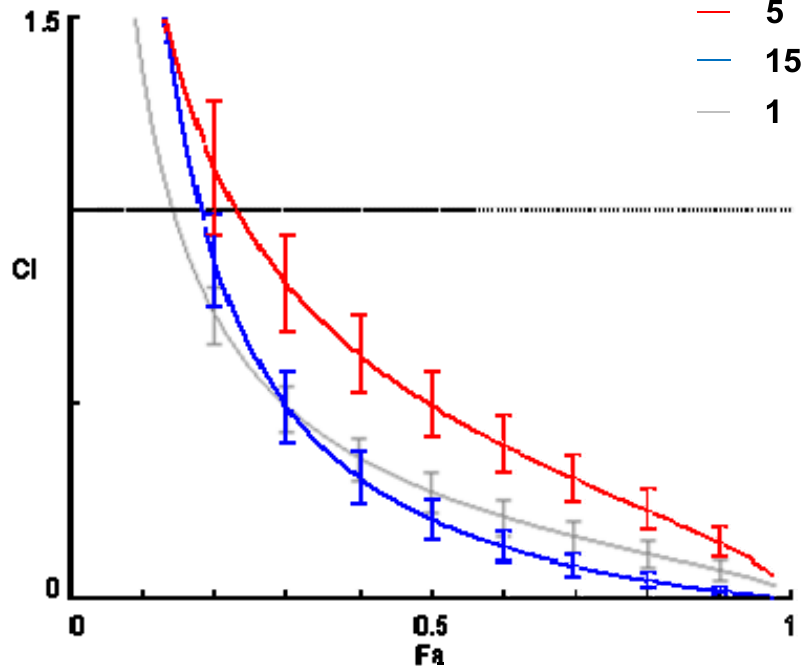
Figure 3. Fraction affected (Fa) vs. combination index (CI) value plot for compounds 5 and 15 , in comparison with the original lead compound 1 . Error bars represent 95% confidence intervals by means of serial deletion analysis performed with the CompuSyn software. The 2,3-mono-dioxolane derivative 15 represents significantly stronger synergism with doxorubicin than the corresponding 20,22-dioxolane derivative 5 at practically all activity levels, and above Fa = 0.7 (which, in case of cancer, matters the most [10]) it is also stronger than compound 1